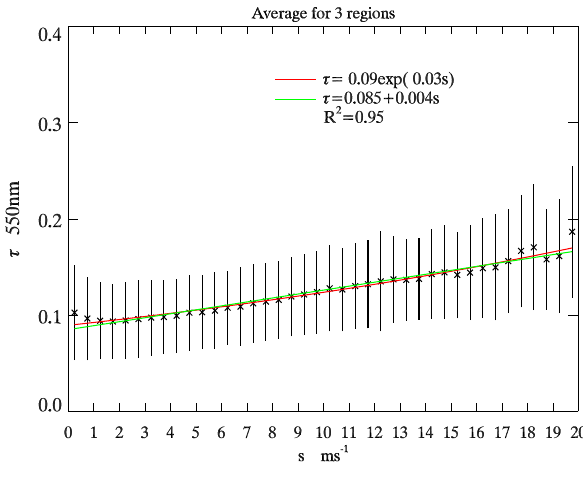
Huang et.al.: Relationship Between Wind Speed and AOD